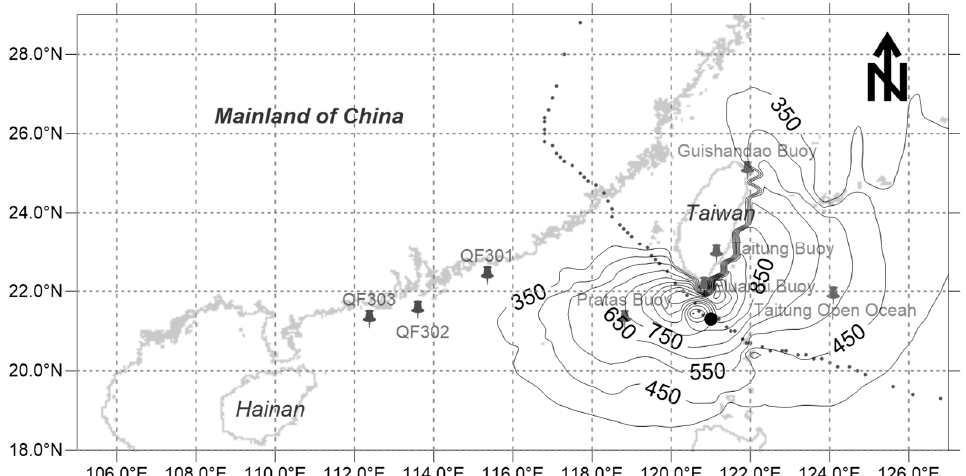
Figure 9. A wave field (unit: cm) induced by the wind field from MH10 (B3-A1-A2) at Eluanbi Station peak wave time during Typhoon Meranti (142016), where the bigger black dot is the location of the typhoon’s center.